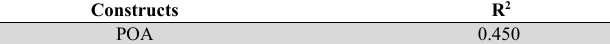
R-squared values